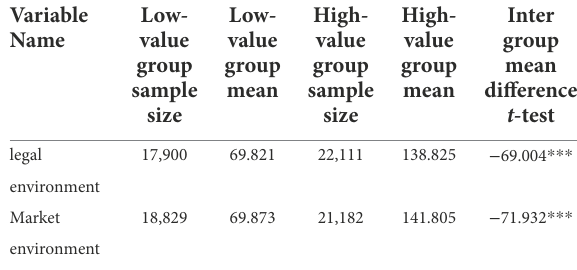
TABLE 4 The relationship between formal institutional environment and industry supervision